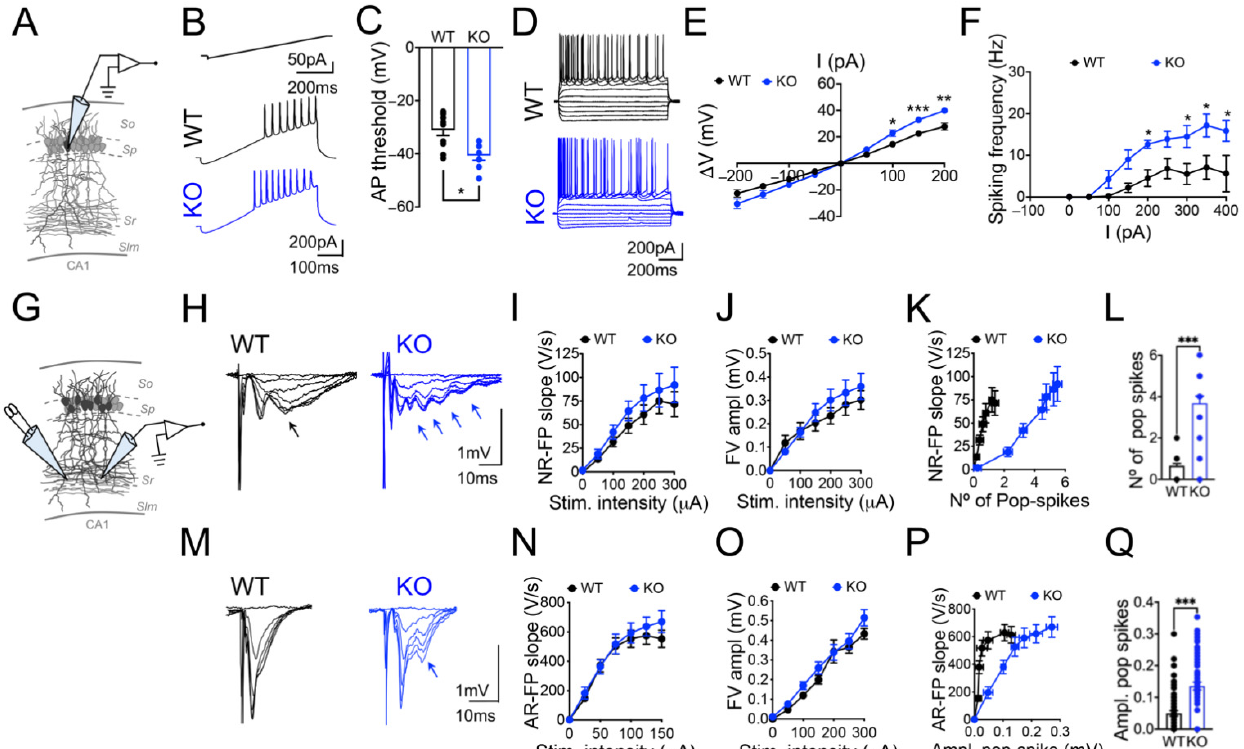
Figure 1. Enhanced excitability but normal glutamatergic synaptic transmission in hippocampal CA1 neurons from Panx1-KO mice. ( A ) Schematic drawing of a whole cell recording in the pyramidal cell layer ( Stratum pyramidale, Sp ) of the CA1 region of a hippocampal slice. ( B ) Representative traces of action potential recordings evoked by a current ramp in CA1 neurons of WT (black) and Panx1-KO (KO, blue) mice. ( C ) Action potential threshold. n = 10 (WT) and n = 8 (KO) cells from 4–5 animals, * p = 0.0108 Mann–Whitney test. ( D ) Representative traces of membrane potential changes in response to the current steps. ( E ) Current-voltage curves. n = 10 (WT) and n = 8 (KO) cells from 4–5 animals, * p < 0.0142, ** p < 0.046 and *** p < 0.001 two-way ANOVA test. ( F ) Spiking frequency in response to the current steps for WT and KO hippocampal cells. n = 10 (WT) and n = 8 (KO) cells from 4–5 animals, * p < 0.0142 two-way ANOVA test. ( G ) Schematic drawing of